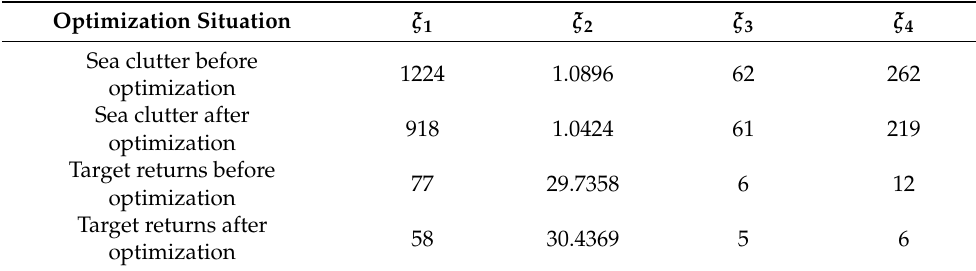
Table 4. Comparison of four features before and after optimization.